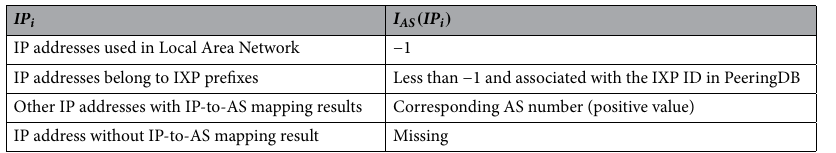
Table 2. Values of I AS ( IP i ) .